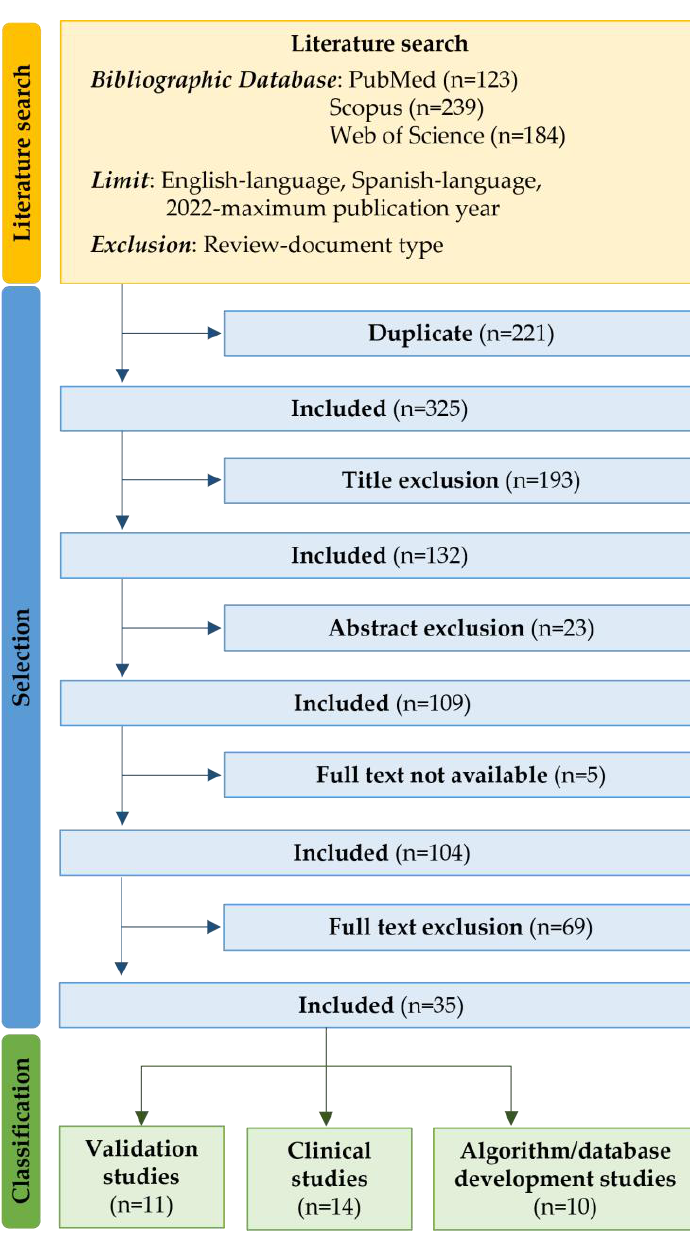
Figure 1. Flowchart of systematic literature search study selection and classification.